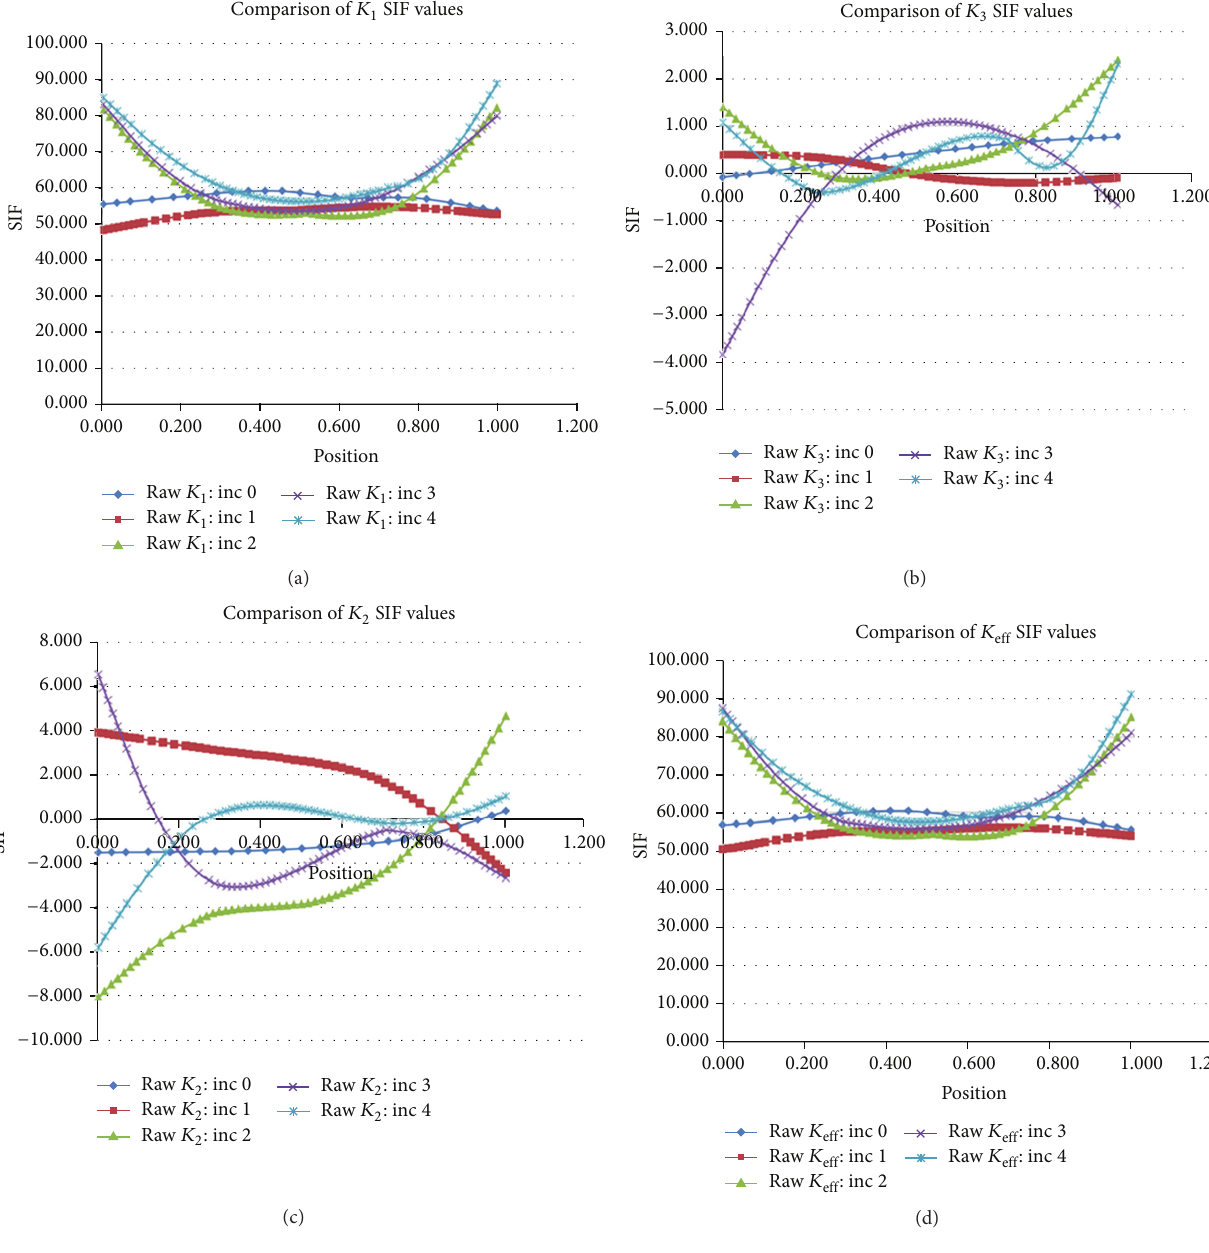
Figure 19: Stress concentration factor of cracks at various growing